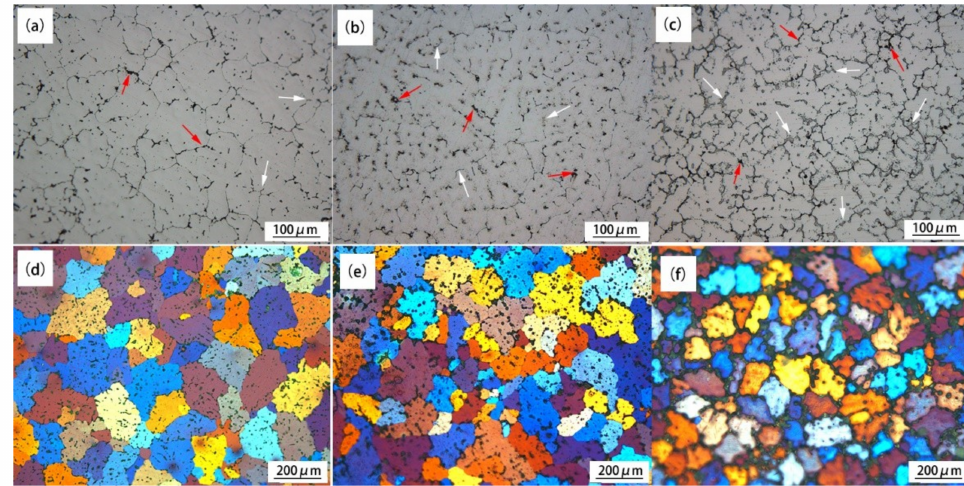
Figure 2. Optical microstructure (OM) and polarized light images of as-cast Al-5.5Mg-xLi-0.1Zr (wt%) alloy with di ff erent Li contents: ( a,d ) 1.6 wt%, ( b,e ) 2.0 wt%, ( c,f ) 2.5 wt%.